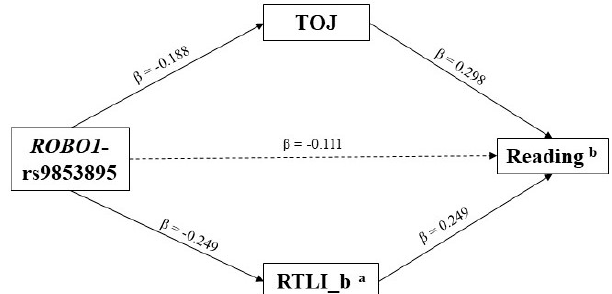
Figure 2. Significant specific indirect effects within the significant total indirect effect from ROBO1-